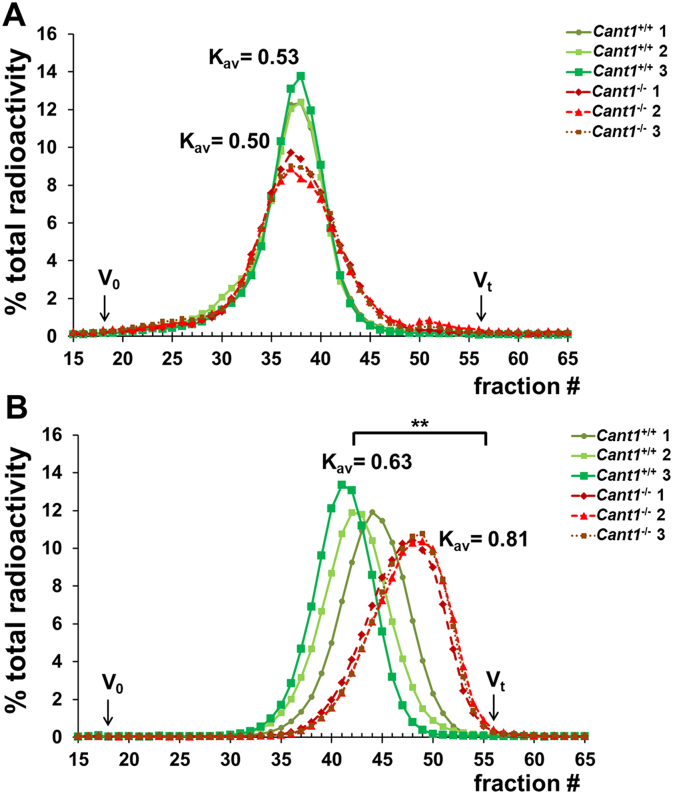
GAG hydrodynamic size is reduced in Cant1−/− mice. (A) Chondrocyte cultures were metabolically labelled with 35S-sulfate for 24 h in basal medium. GAGs were released from PGs by β-elimination and their hydrodynamic size was analysed by gel filtration chromatography. GAG hydrodynamic size of Cant1−/− chondrocytes was comparable with Cant1+/+ cells even if a slight peak broadening toward the total volume (Vt) was observed. Data are representative of two independent experiments. (B) Cant1−/− and Cant1+/+ chondrocyte cultures were metabolically labelled with 35S-sulfate in basal medium containing 1 mM p-nitrophenyl-β-d-xylopyranoside, an enhancer of GAG synthesis. GAG hydrodynamic size was analysed by gel filtration chromatography. A marked shift toward the Vt was found in Cant1−/− chromatograms demonstrating that Cant1−/− GAGs have reduced size compared with wild type controls. Data are representative of two independent experiments and Kav is reported as mean. Significance was determined by Student's t-test, ** P < 0.01.